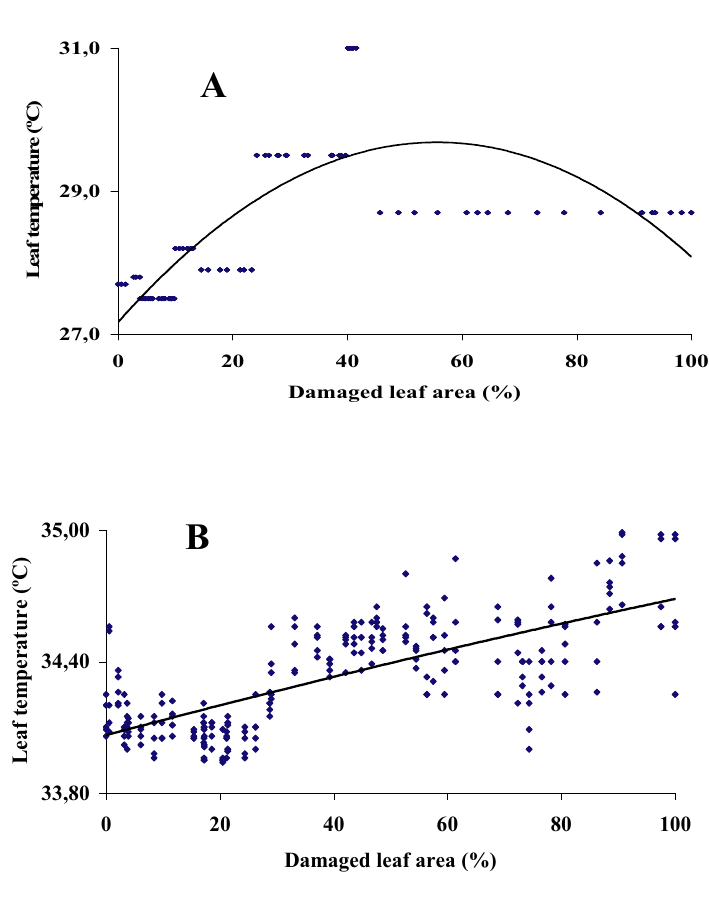
Fig. 6 – Effect of leaf area damaged (0 to 100%) by O. praelonga (A) and L. coffeella (B) on the temperature ( ◦ C) of rangpur lime and Obatã coffee leaves,